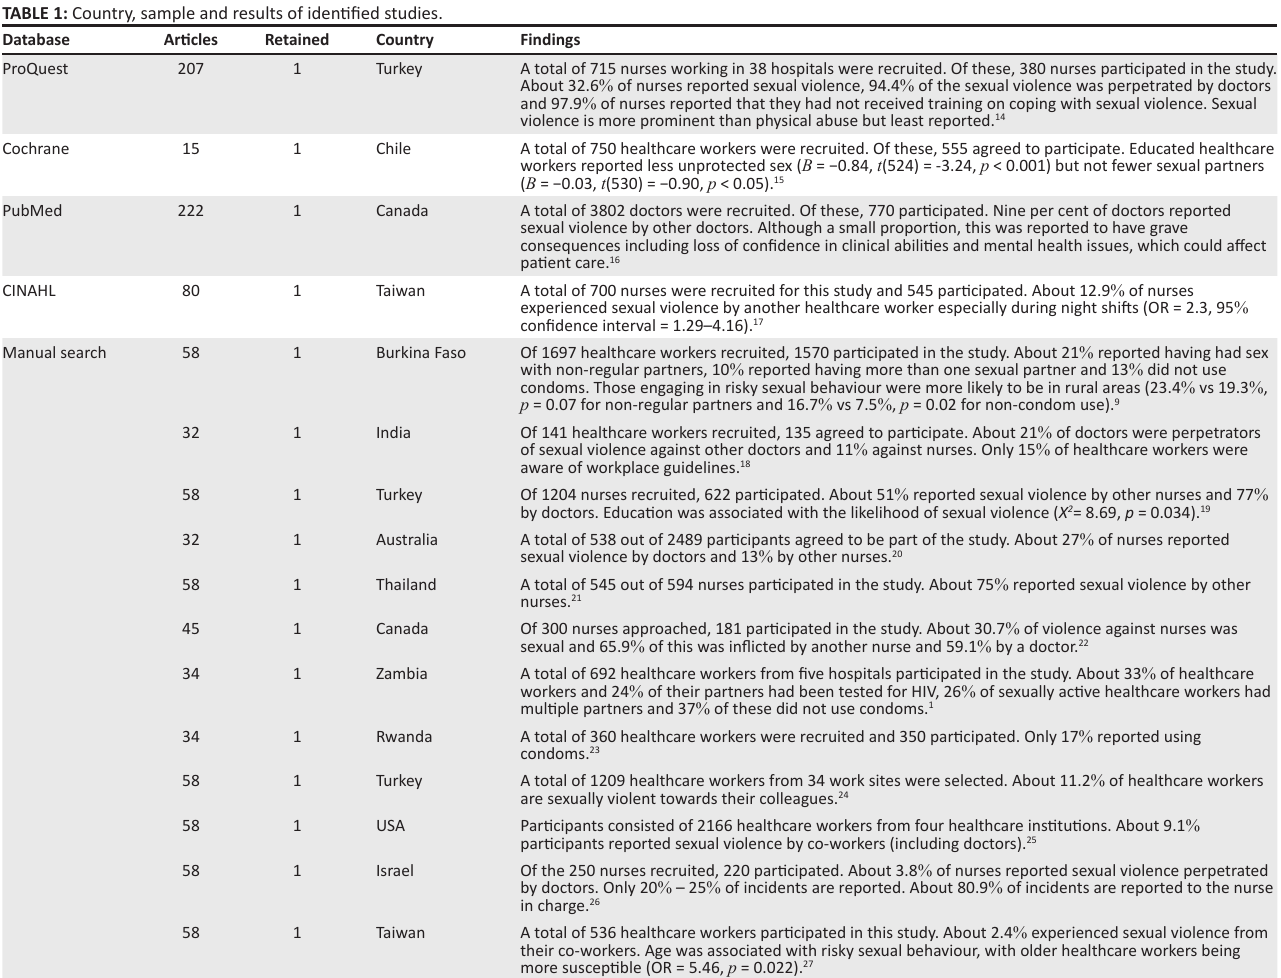
TABLE 1: Country, sample and results of identified studies. Database